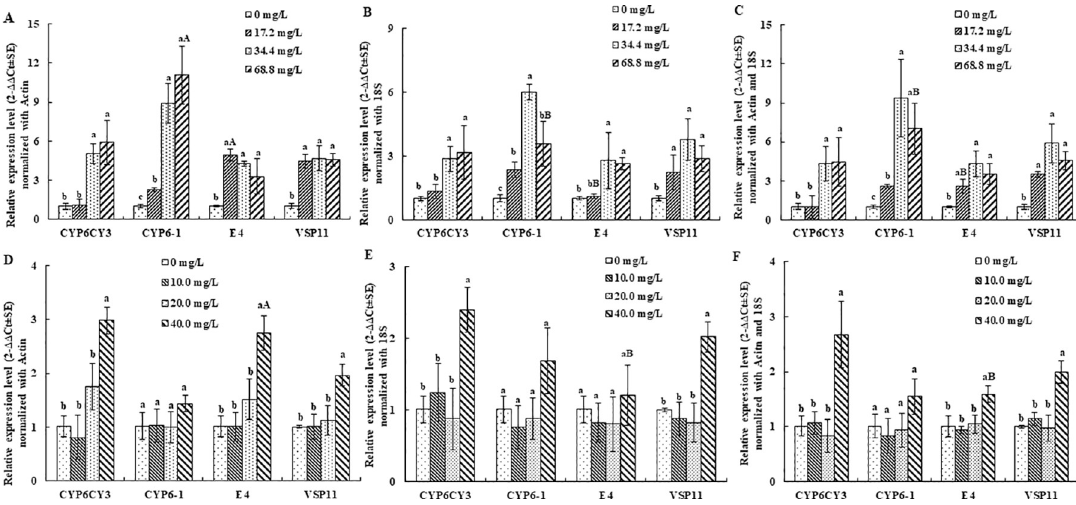
Fig 2. Fold expression of four target genes normalized to Actin and 18S under insecticide treatment. A, B, C, Relative expression levels normalized to Actin and 18S alone and in combination under the flonicamid treatment; and D, E, F, relative expression levels normalized to Actin and 18S alone and in combination under the pymetrozine treatment. Values are shown as the mean ± SEM. Bars with different letters are significantly different from each other ( P < 0.05). Lowercase letters indicate the comparison among different concentrations for one target gene normalized with the same housekeeping gene. Uppercase letters represent the comparison among different normalized genes for one target gene under the same treatment of one insecticide.